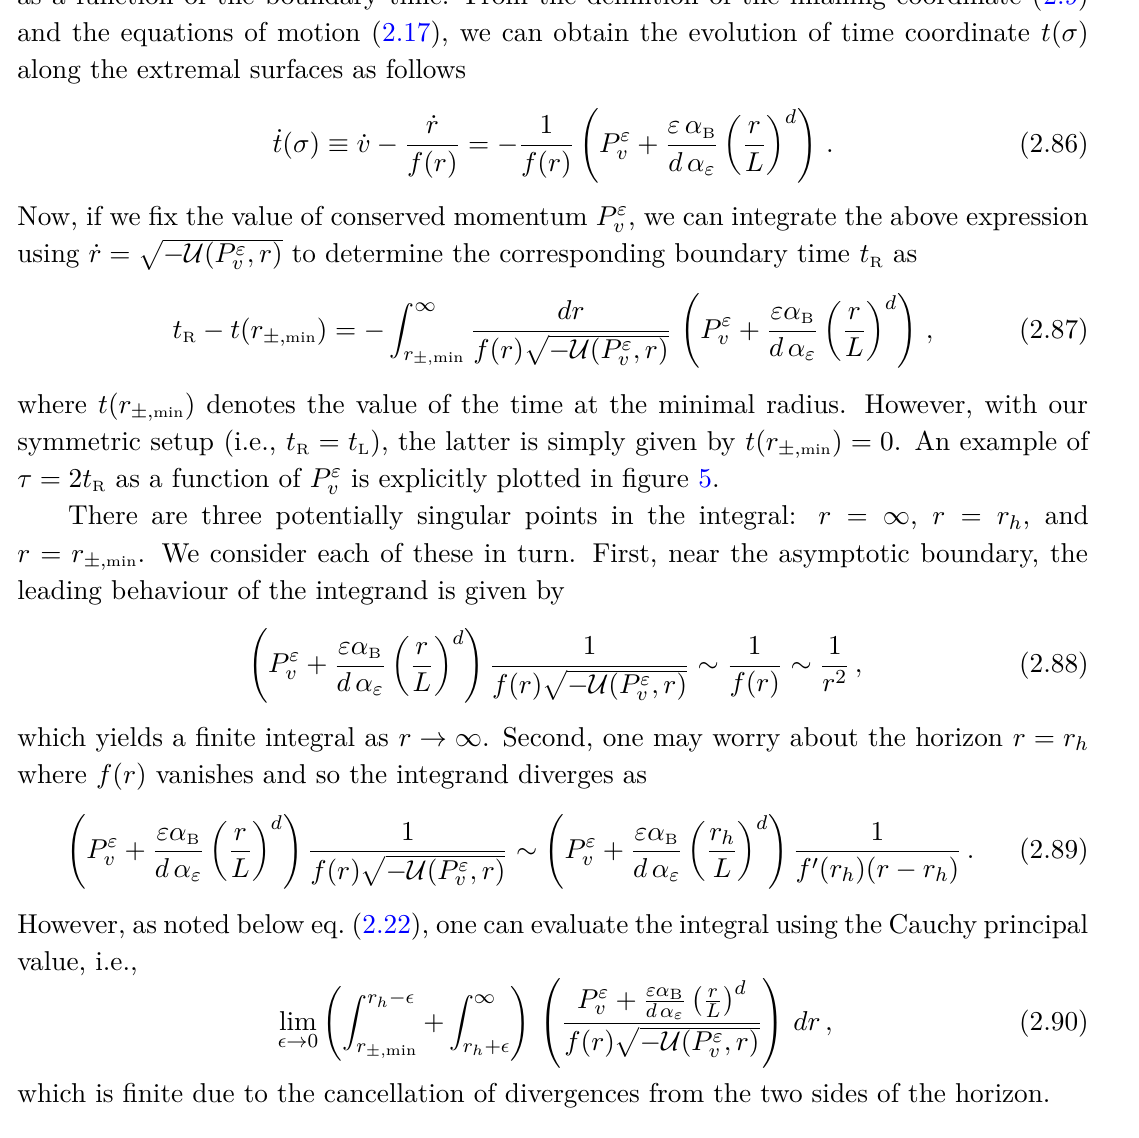
as a function of the boundary time. From the definition of the infalling coordinate